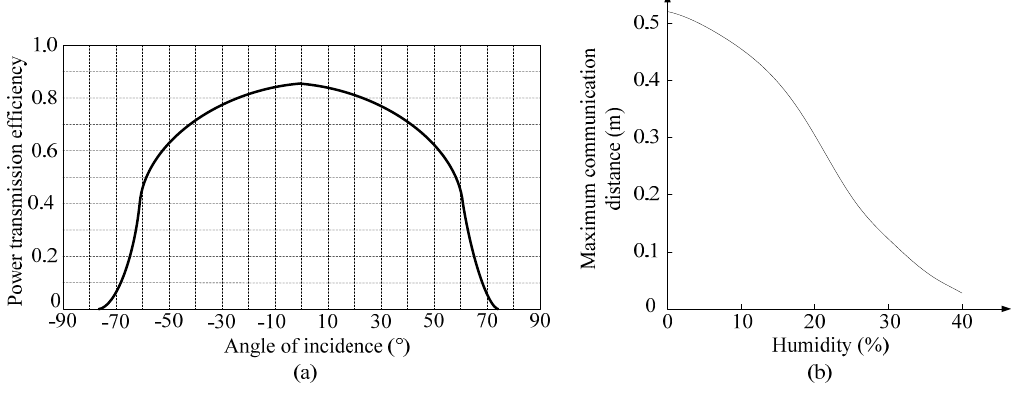
Figure 18. ( a ) Influence of incidence angle on power transmission; ( b ) Influence of concrete humidity on power transmission.